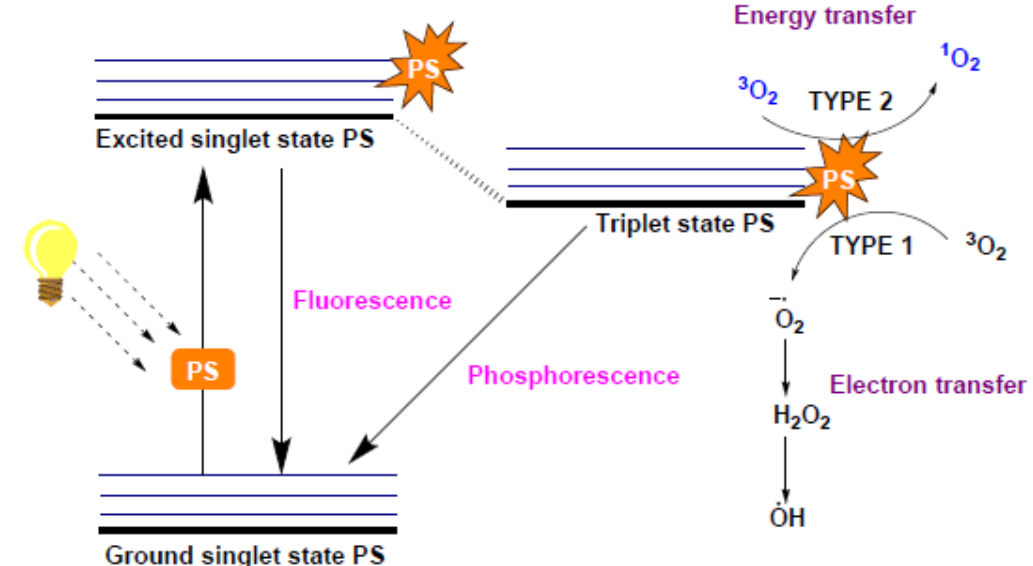
Figure 15. Schematic illustration of the generation of reactive oxygen species (ROS) via the transfer of excitation energy between a photosensitizer in its excited triplet state and molecular oxygen under irradiation. Reproduced by permission of The Royal Society of Chemistry (RSC) on behalf of the European Society for Photobiology, the European Photochemistry Association, and RSC [34].